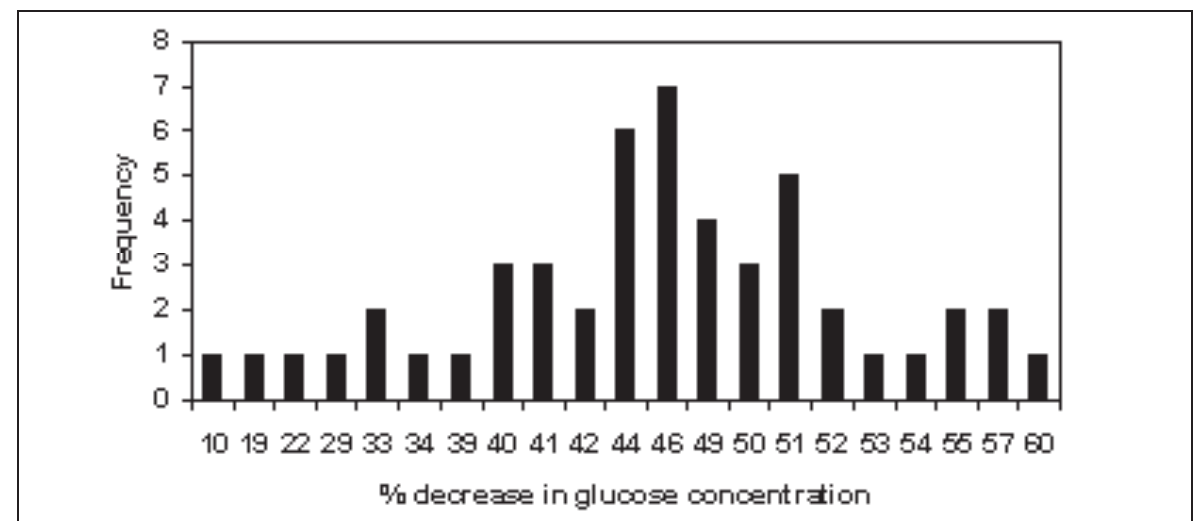
Fig. 2: Frequency distribution of variation in glucose values following processing of replicate smaples after 24 hours of serum-clot contact.